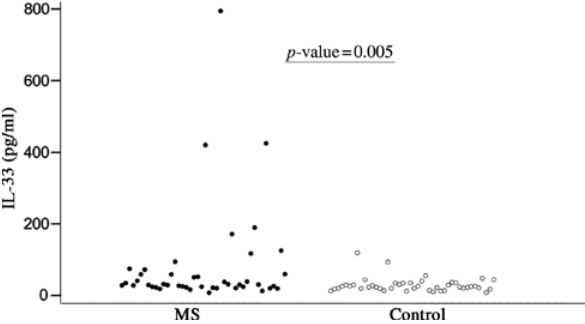
Figure 3: Comparison of IL-33 plasma levels in RRMS patients and healthy